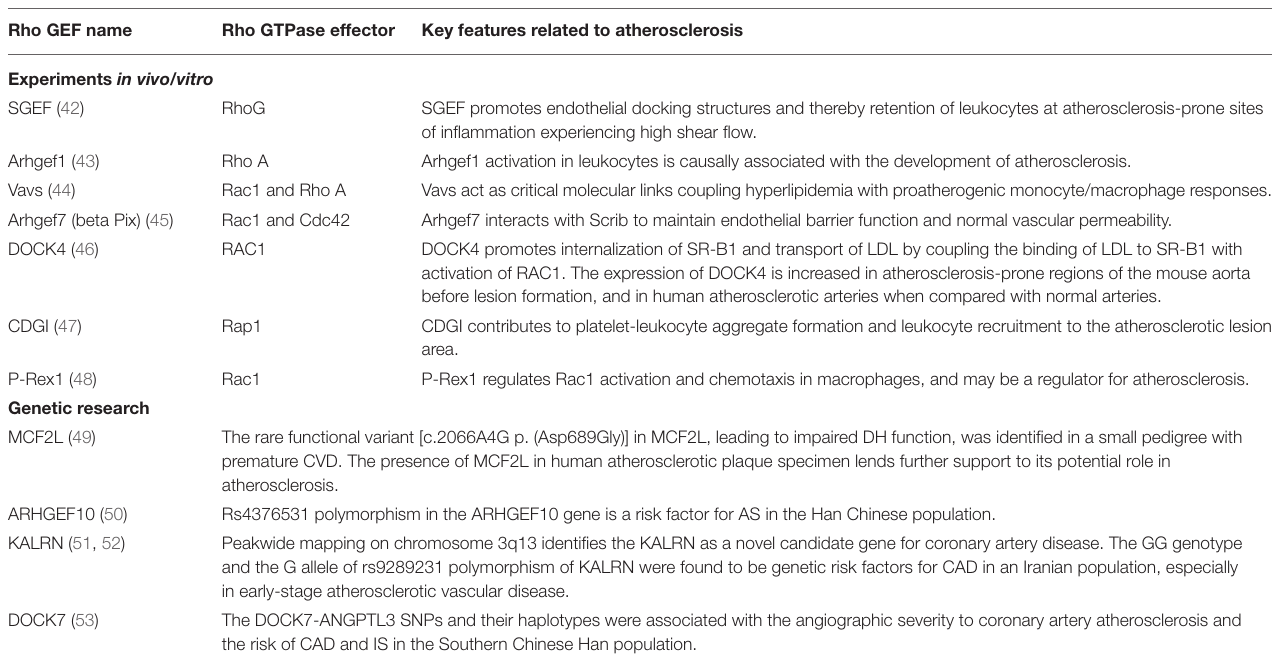
TABLE 1 | Direct evidence of Rho GEF regulation of